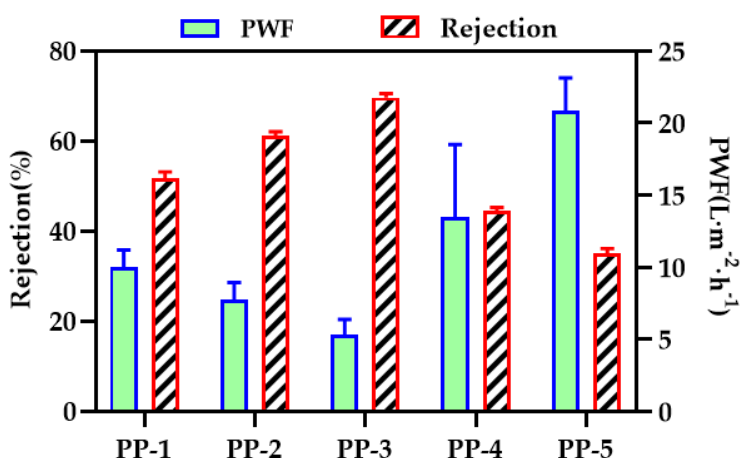
Figure 13. Pure water flux and BSA rejection rates of various PES/PEI membranes.